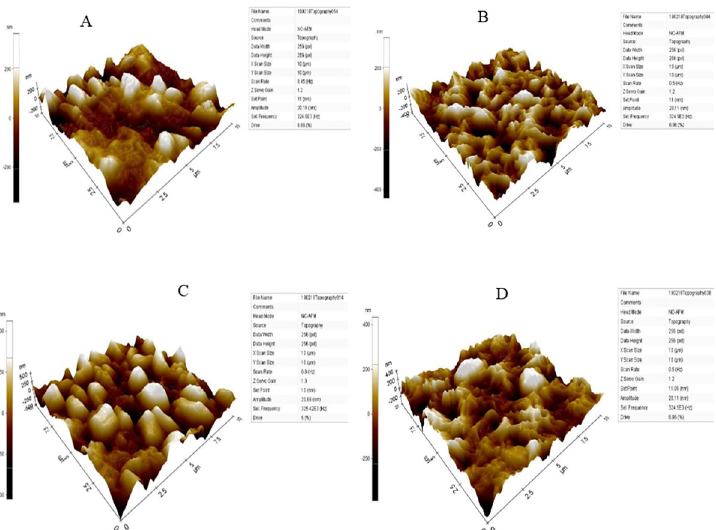
Fig 4. Atomic force micrographs of E . coli and S . aureus cell surface before and after inactivation with 0.028 mg mL -1 of Cu/Zn NPs, at pH 6 and after 60 min; a) untreated E . coli ; b) treated E . coli ; c) untreated S . aureus ; e) treated S . aureus